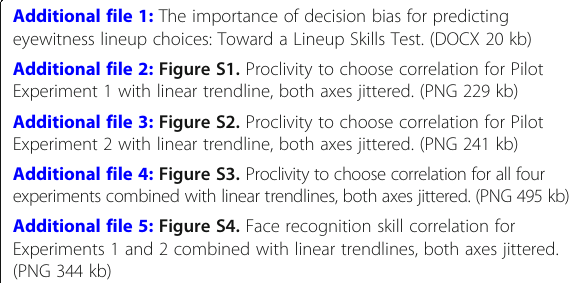
Additional file 4: Figure S3. Proclivity to choose correlation for all four experiments combined with linear trendlines, both axes jittered. (PNG 495 kb) Additional file 5: Figure S4. Face recognition skill correlation for Experiments 1 and 2 combined with linear trendlines, both axes jittered. (PNG 344